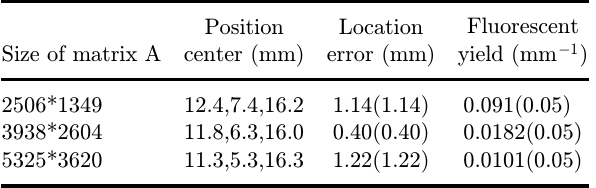
Table 5. Impact of di®erent meshes on the proposed method.